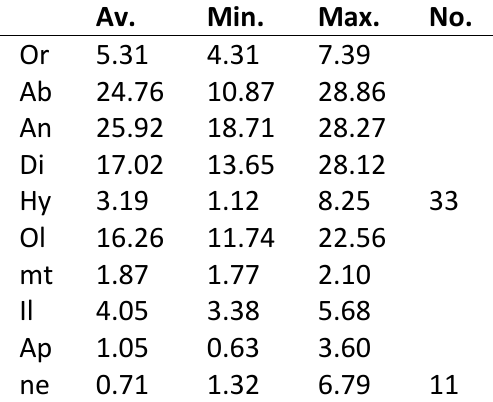
Table 3. CIPW-normative mineral